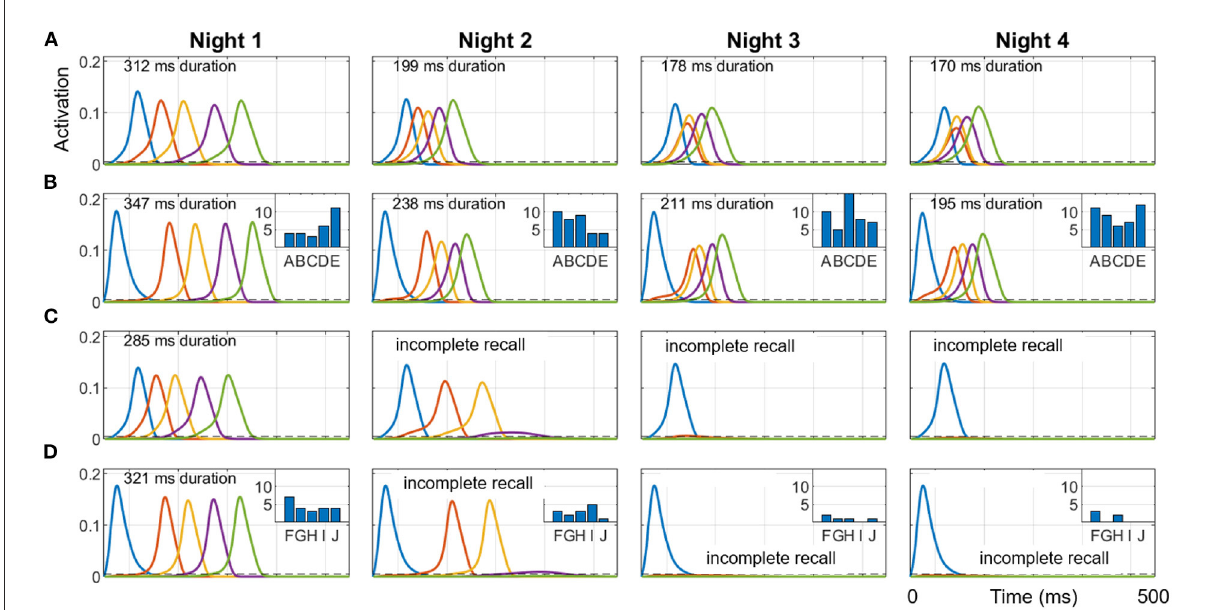
FIGURE7 Representative replays of two separate sequences during a four-day, four-night simulation. Sequences ABCDE and FGHIJ were trained for 10 trials each on Day 1, and then only ABCDE was trained for 10 trials per day on Days 2, 3, and 4. 50 cycles of 1 Hz SWO were run each night. The last full replay for each of the four nights (cued by the first item in each sequence) within the respective 500 ms UP state is plotted here. (A) ABCDE replay in the hippocampus each night. (B) ABCDE replay in the cortex with inset histogram of the number of replays cued by each item during the night. (C) FGHIJ replay in the hippocampus each night. (D) FGHIJ replay in the cortex with inset histogram of the number of replays of each item during the night. Due to lower salience, replays of FGHIJ die out after Day 2. Note the first item is activated by the replay cue. The duration of replay is printed at the top of each plot, which is calculated only when all items in the sequence get